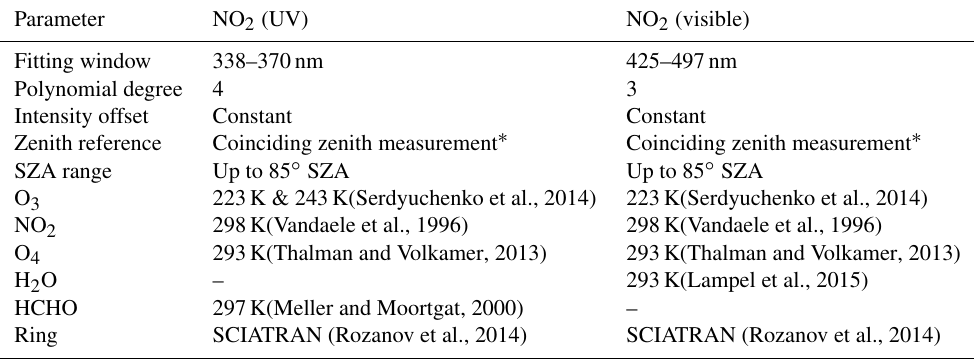
Table 1. DOAS fit settings for the retrieval of NO 2 and O 4 in the UV and visible spectral ranges. Parameter